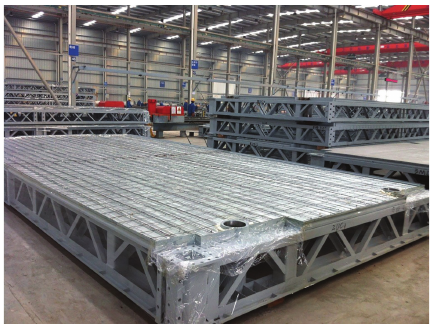
Figure 2: Main floor.